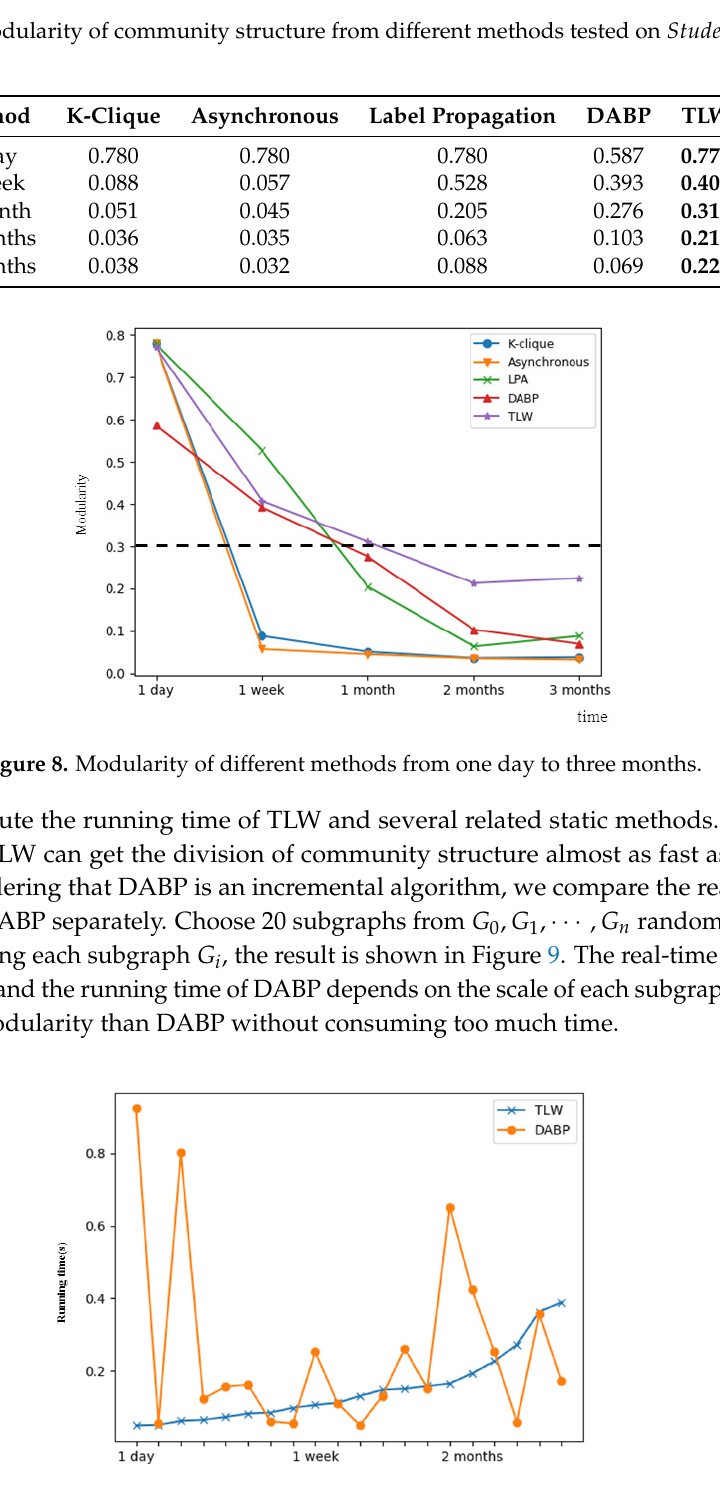
Figure 9. Real-time running time of TLW and